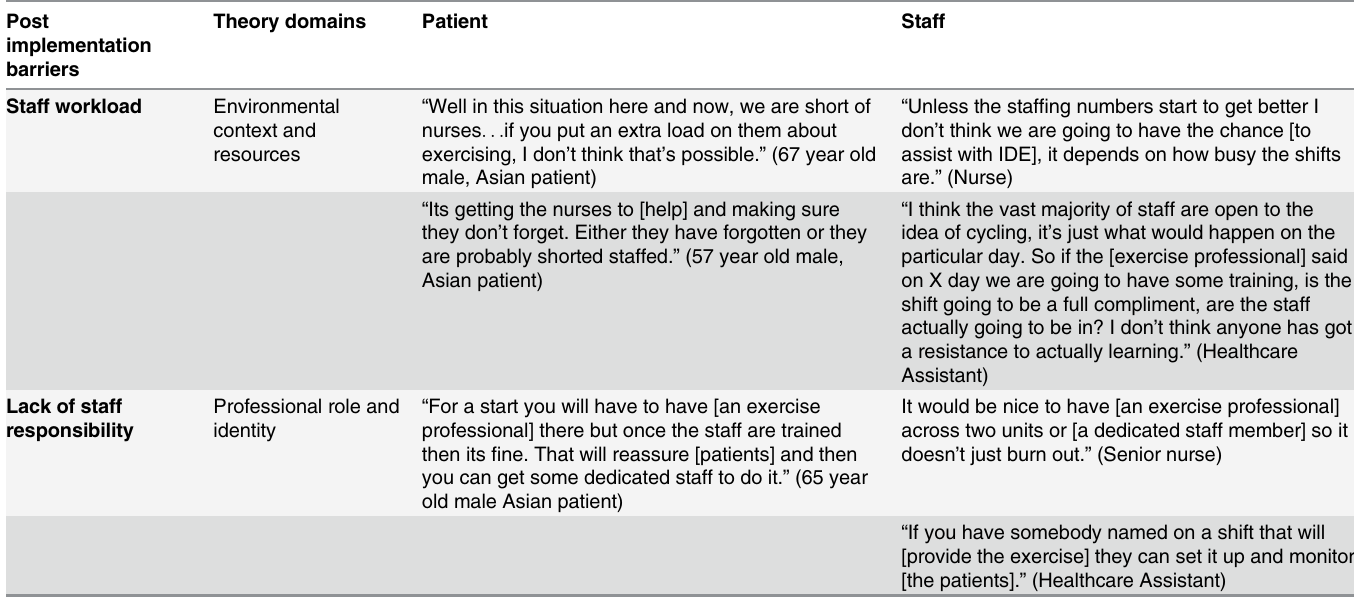
Table 4. Barriers to IDE post-implementation, as identified by patients and